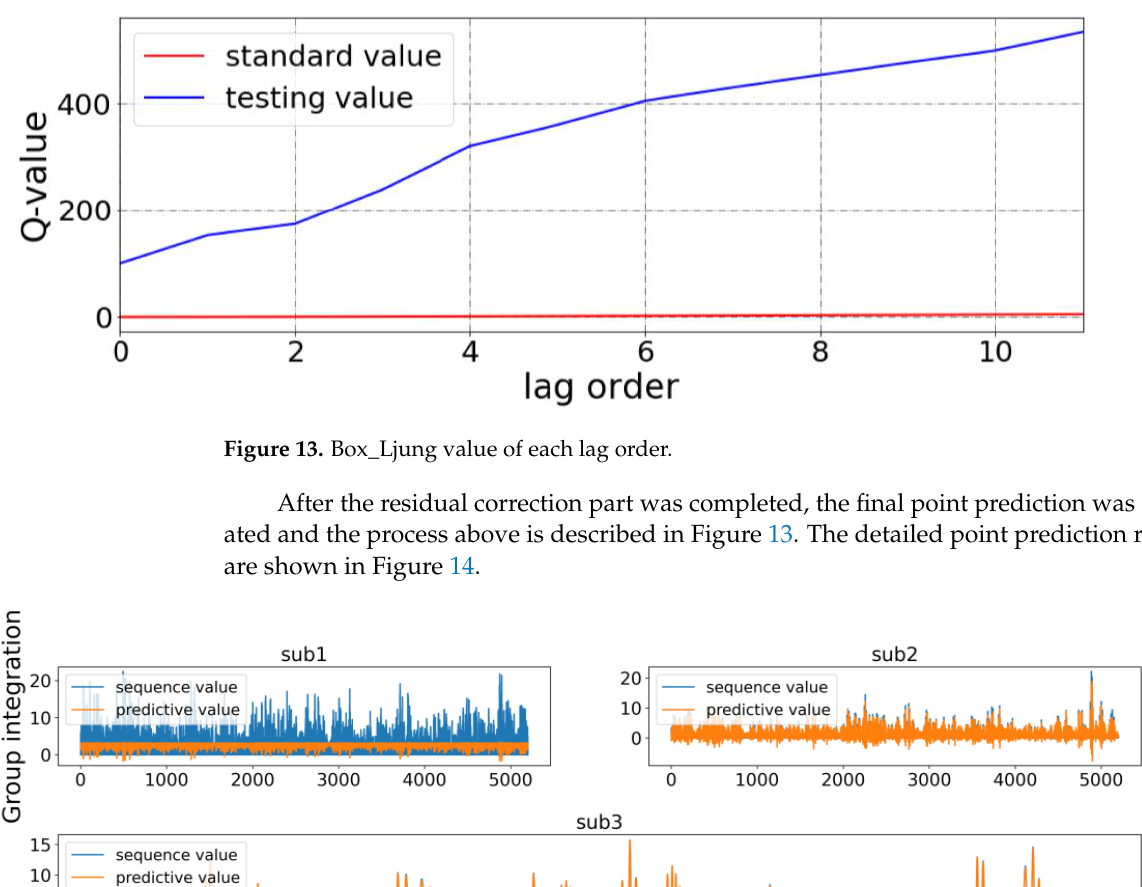
Figure 12. The three subfigures represent three subsequences which are generated through de- composition and dimension reduction from the original time series in case 3.